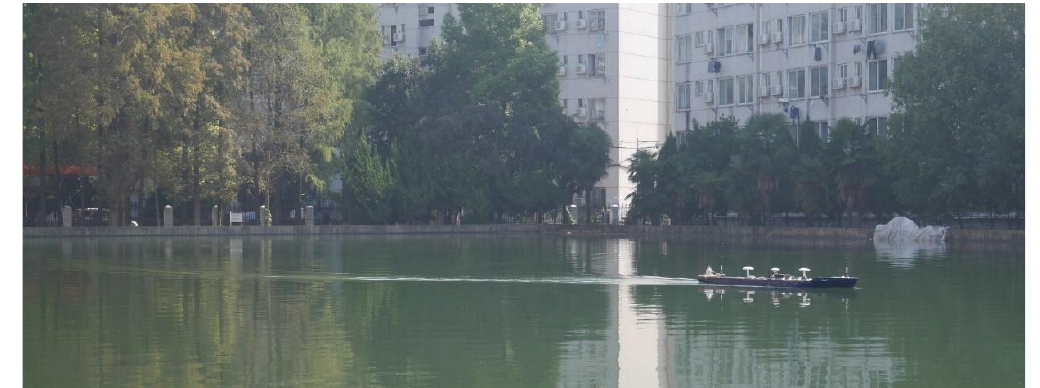
Figure 5. Objective view of the physical model. Table 1. Physical model parameters.